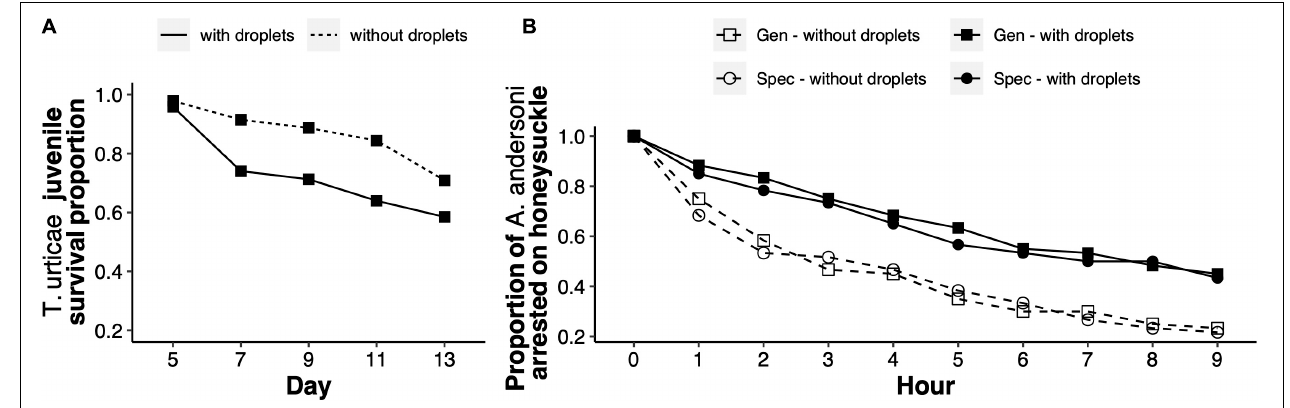
FIGURE 2 | Sticky droplets on honeysuckle leaves as a direct and indirect defence mechanism. (A) Survival proportion of Tetranychus urticae generalist juveniles on honeysuckle leaves either with sticky droplets (solid line), or without sticky droplets (dashed line). Survival proportion was measured across five consecutive time points, spanning from egg hatching in day five, to reaching adulthood by day 13. (B) Proportion of Amblyseius andersoni adult females on honeysuckle leaves with previous herbivory from either generalist or specialist spider mites, and in which sticky droplets were either kept or removed manually (legend), across nine consecutive